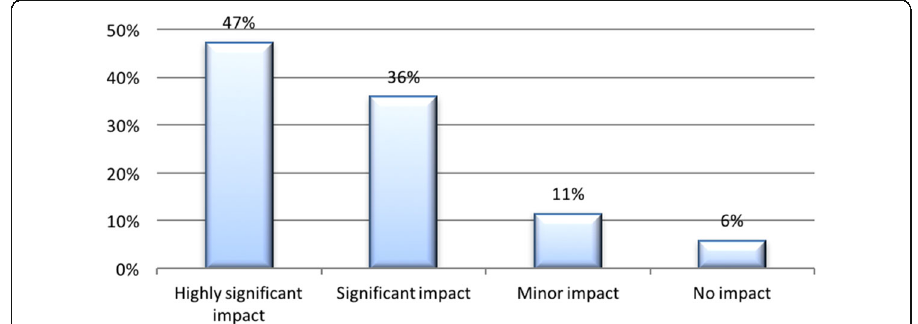
Fig. 8 Student perceptions of the effect of discussion boards to enhance their